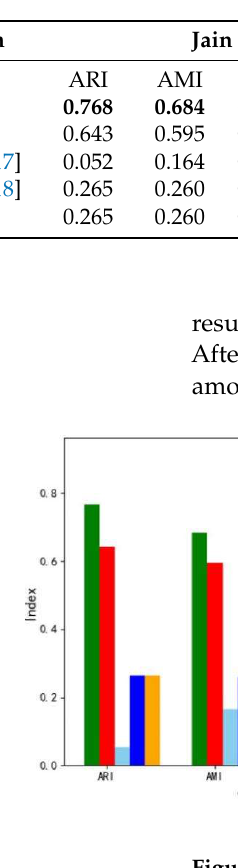
Table 1. Evaluation of clustering indicators for each dataset.